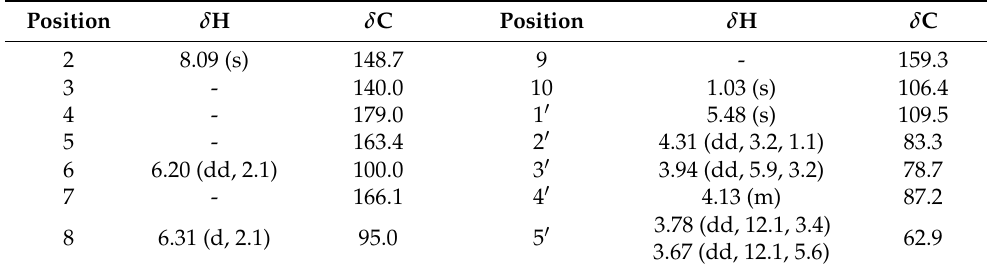
Table 2. 1 H-NMR (600 MHz, methanol- d 4 ) and 13 C-NMR (150 MHz, methanol- d 4 ) of compound 12 .